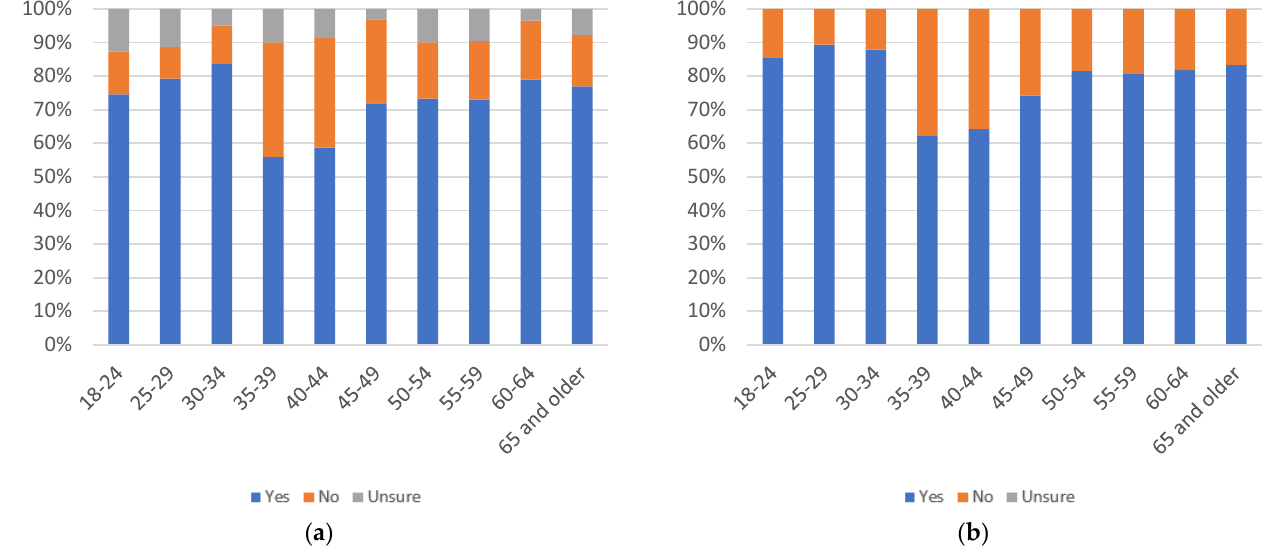
Figure 53. Label helpfulness, by age group: ( a ) with uncertain respondents (left) and ( b ) without uncertain respondents (right).